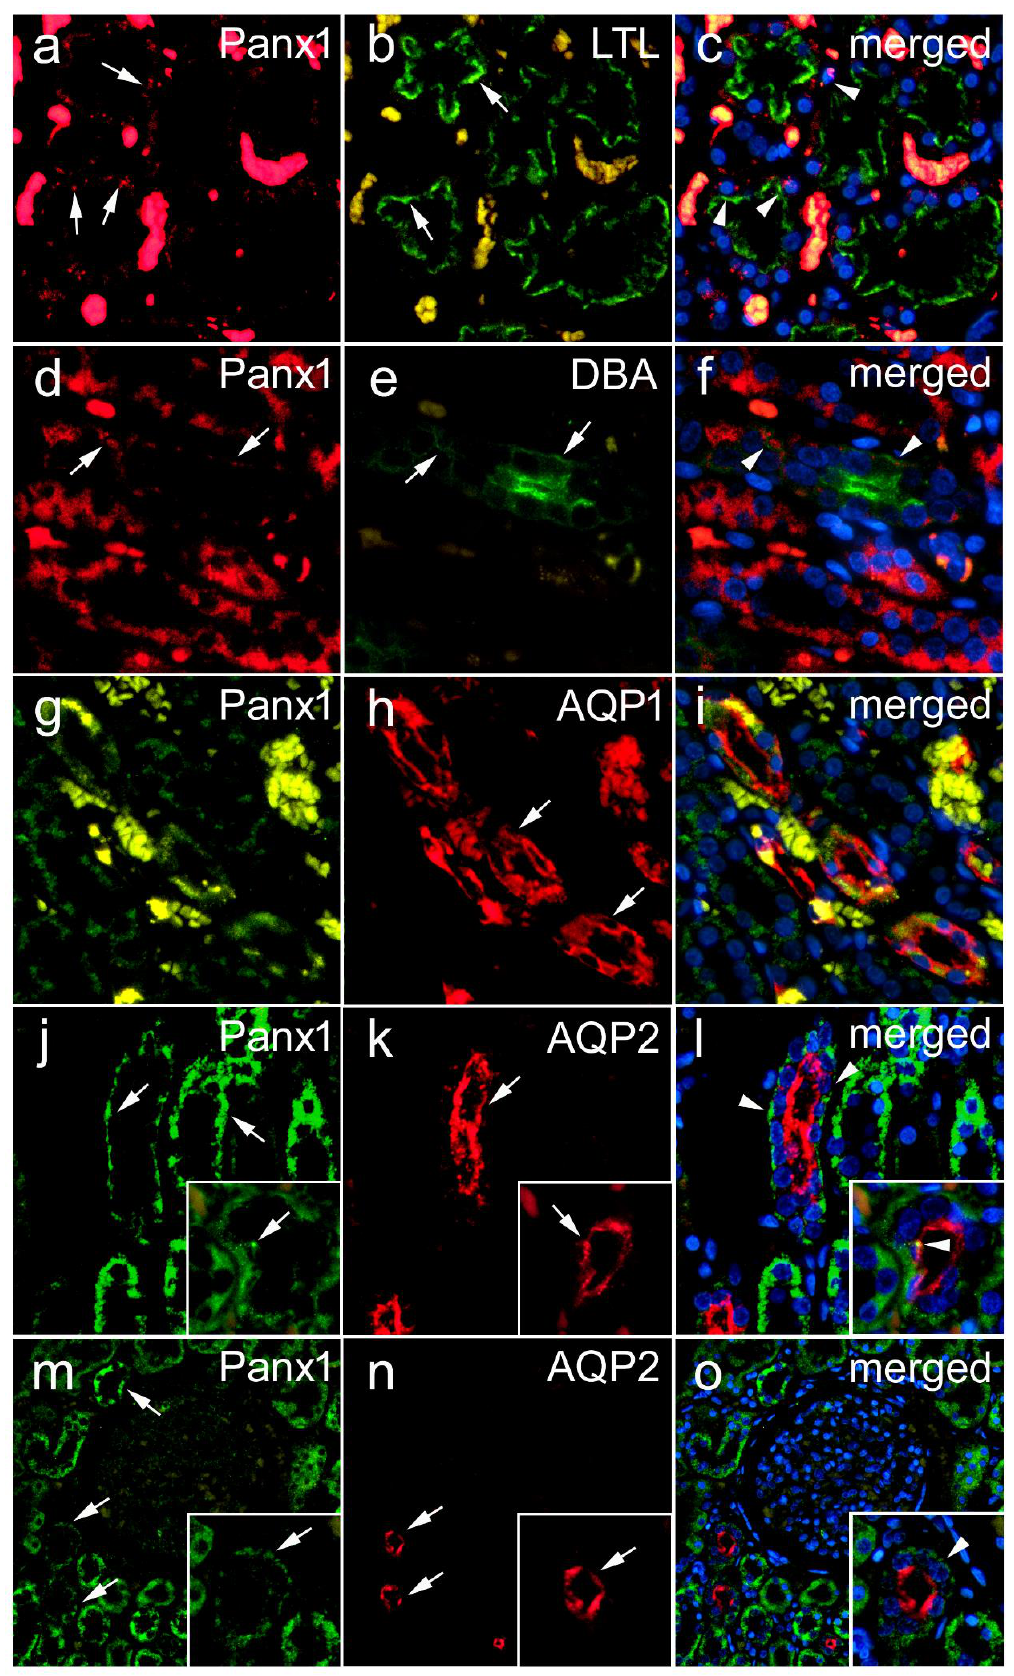
Figure 4. Expression of Panx1 in different tubular segments of postnatal human kidney. Double